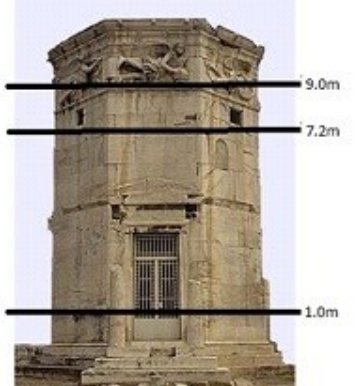
Figure 4: The positions of the horizontal section plans